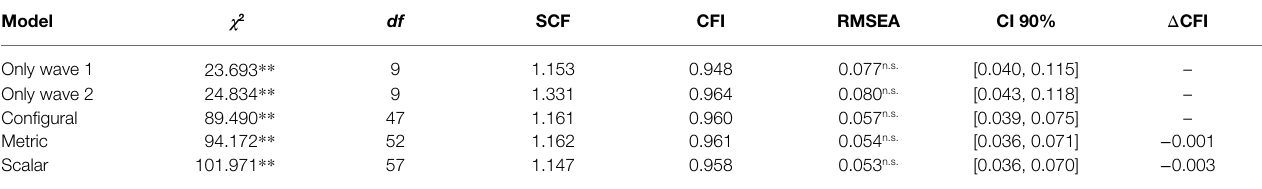
TABLE 6 | Longitudinal measurement invariance of OB-GSE across waves 1 and 2. Model